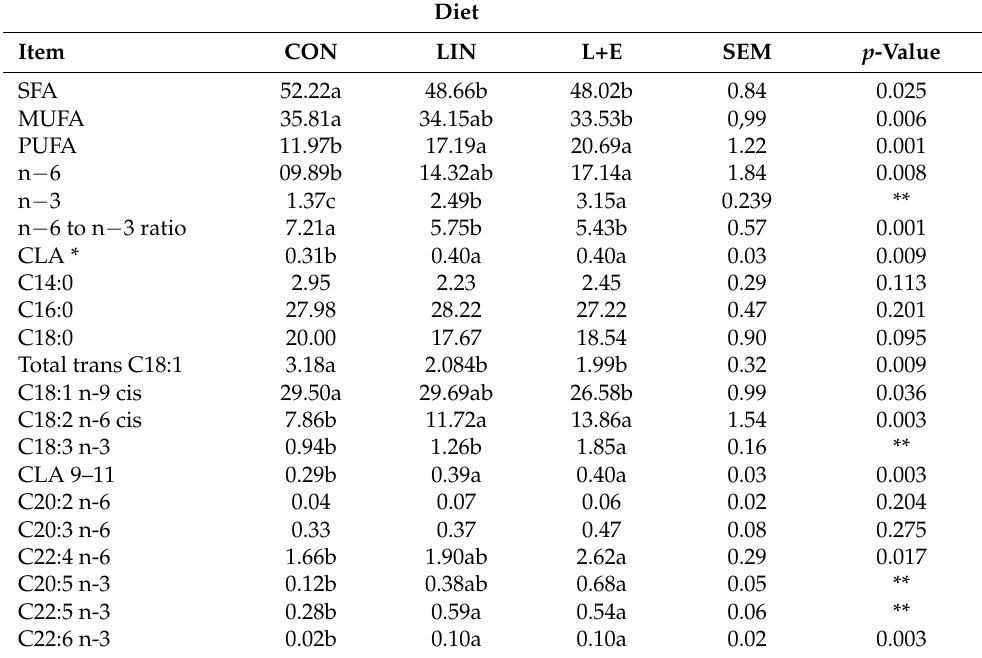
Table 4. Effects of linseed and of high levels Vitamin E in dietary supplementation on principal intramuscular fatty acid composition (% total fatty acids) in the Longissimus thoracis from young bulls Charolaise × Podolica.